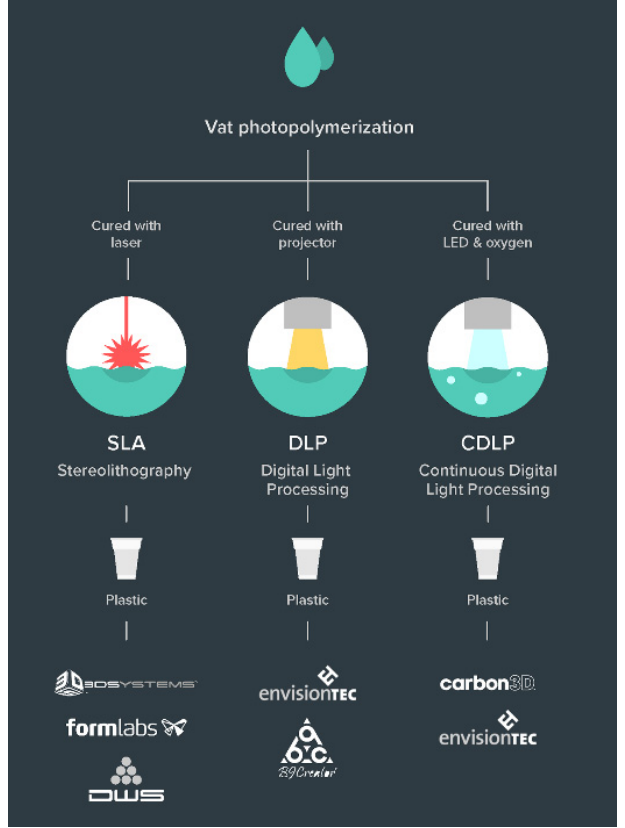
Figure 4. Types of vat photopolymerisation technologies [67].